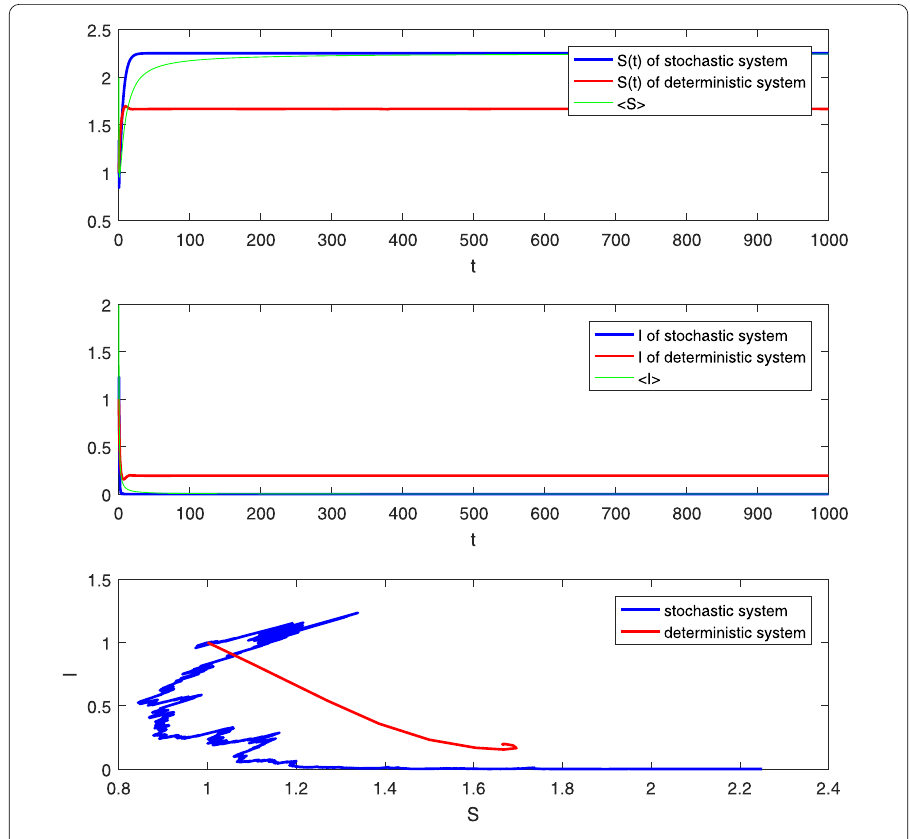
Figure 3 Comparison illustration for S ( t ), I ( t ) of deterministic system and stochastic system with σ = 0.4, Λ = 0.45, μ = 0.2, β = 0.5, γ = 0.79, α = 0.4, p = 2, where R = 1.8210 >